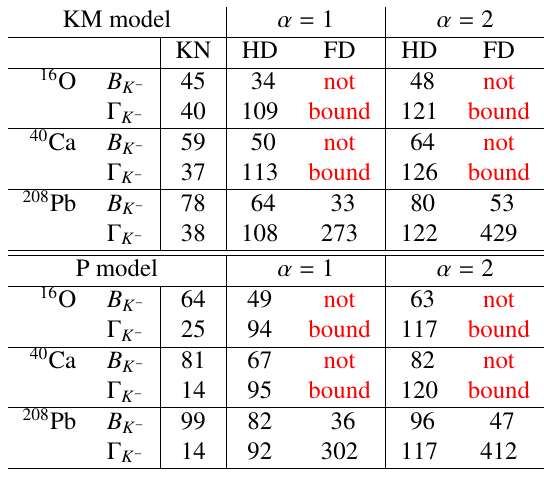
Table 2. 1s K − binding energies B K − and corresponding widths Γ K − (in MeV) in various